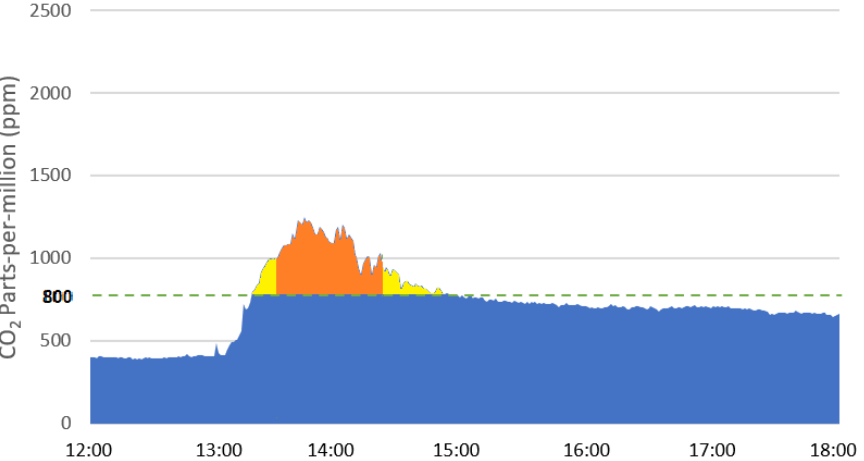
Figure 12. Test C: Full attendance classroom with dynamic ventilation. Ventilator operation starts above the 800 ppm line.